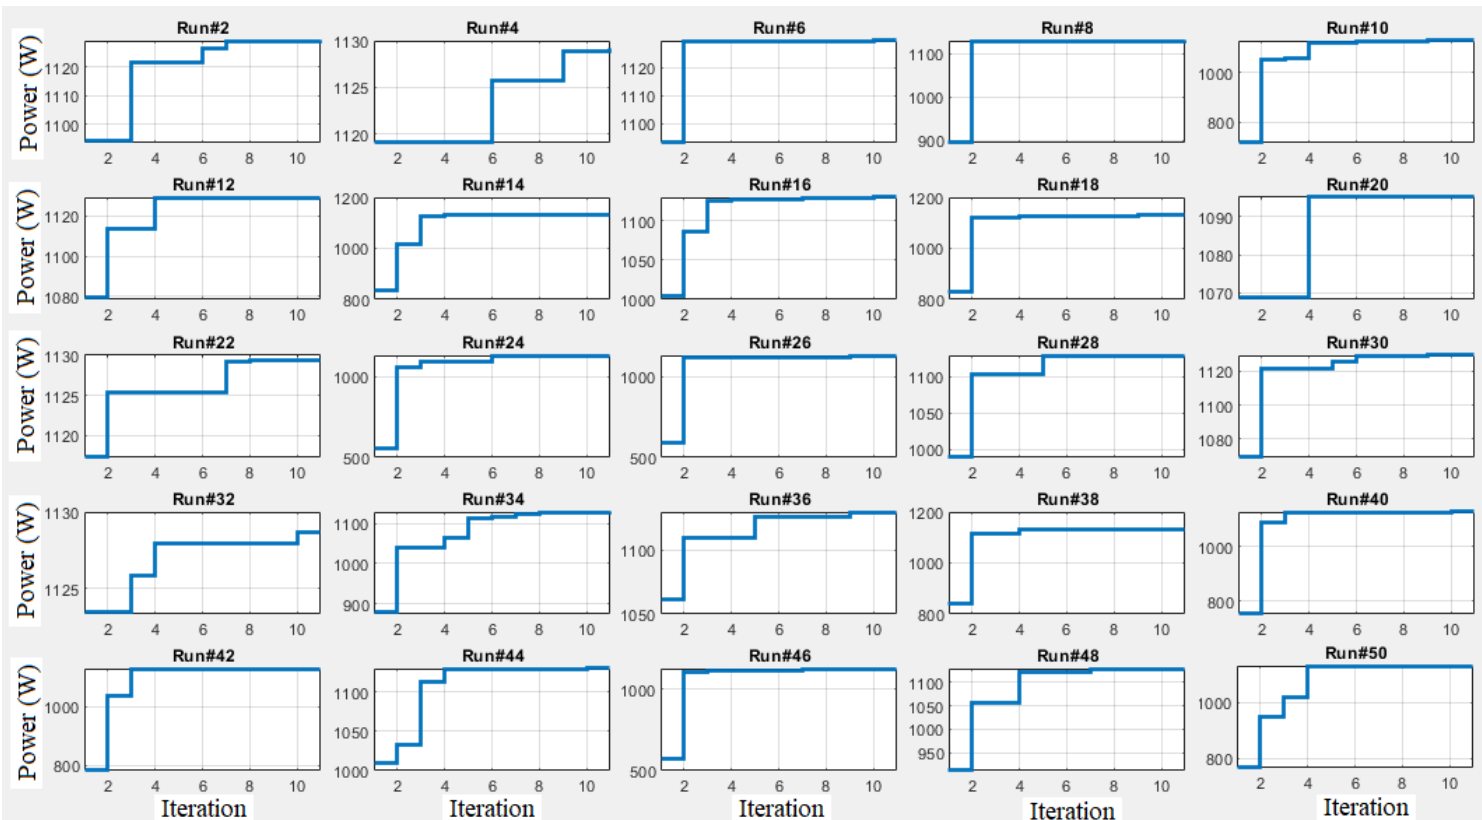
Figure 6. The PV power variation during optimization process using SFS based tracker under fourth shading scenario.